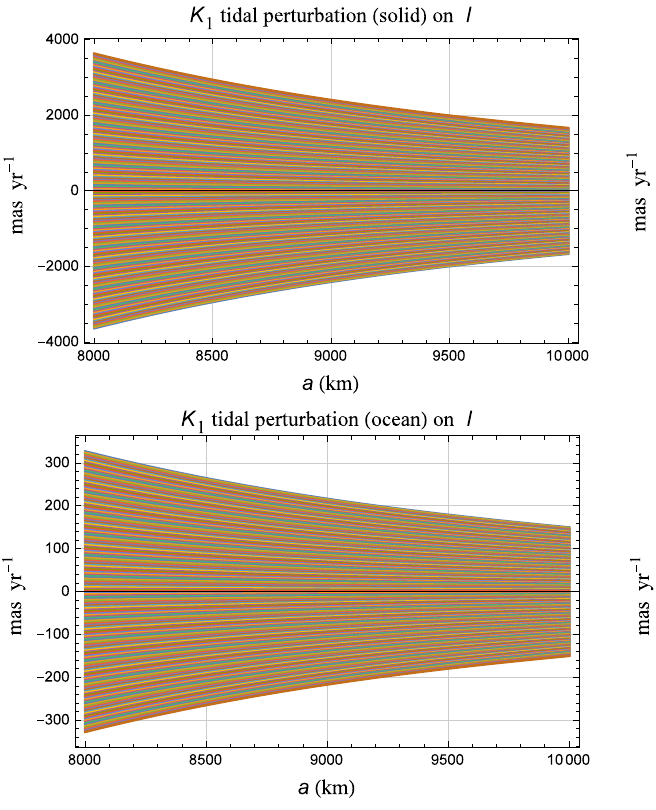
Fig. 1 Nominal amplitudes, in mas year − 1 , of the rates of change of the satellite’s inclination I induced by the solid (upper row) and ocean prograde(lowerrow)componentsofthe K 1 tidefor (cid:5) = 2 , m = 1 , p = 1 , q = 0 from Eqs. (17) to (18) as a function of the semimajor axis a for different values of I in the range 80 ◦ ≤ I ≤ 100 ◦ . The current